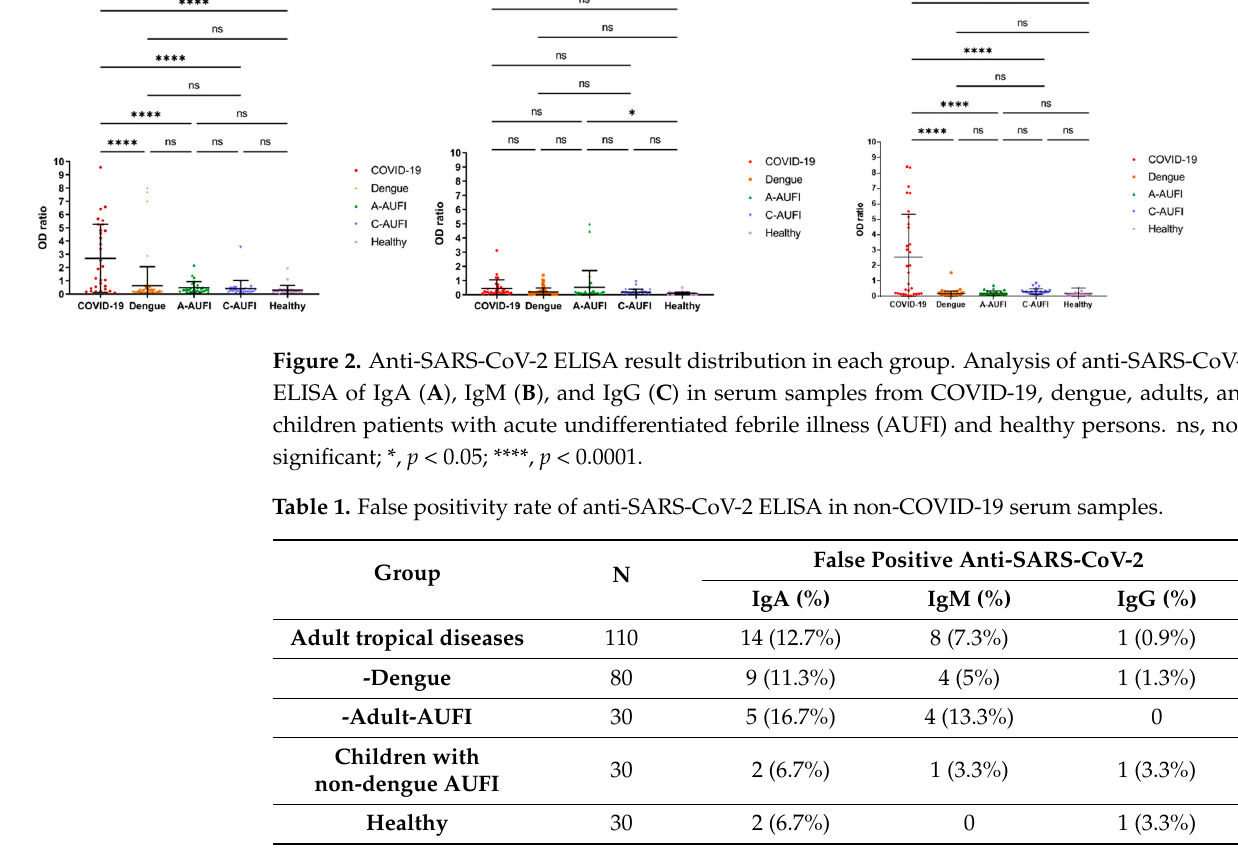
Table 2. List of patients and healthy individuals with borderline and false positive anti-SARS-CoV- 2